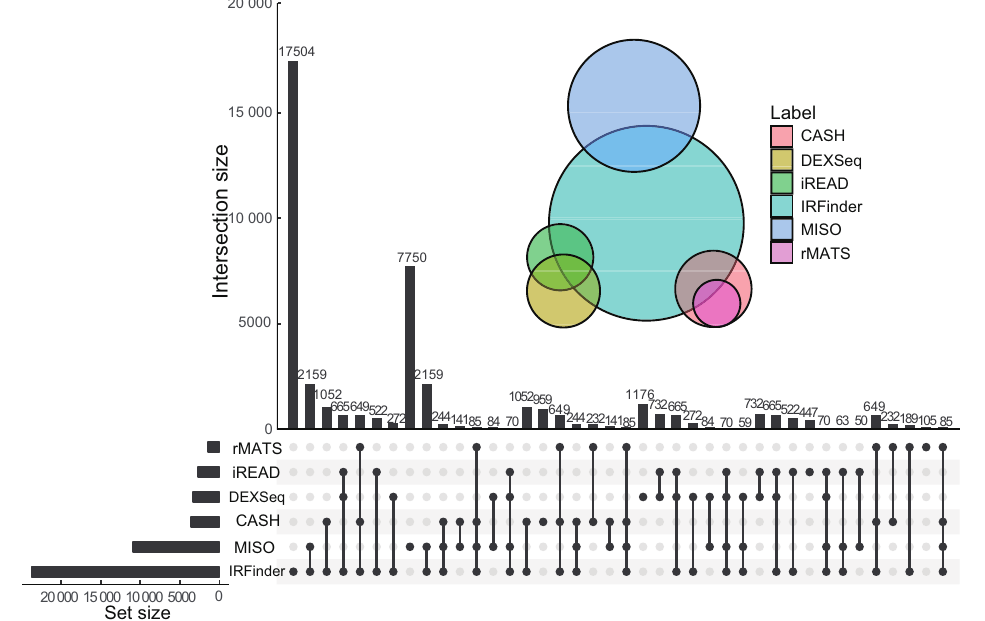
Fig. 4 Venn and UpSet diagram showing the IR intersection of six methods on the APP mutant mouse